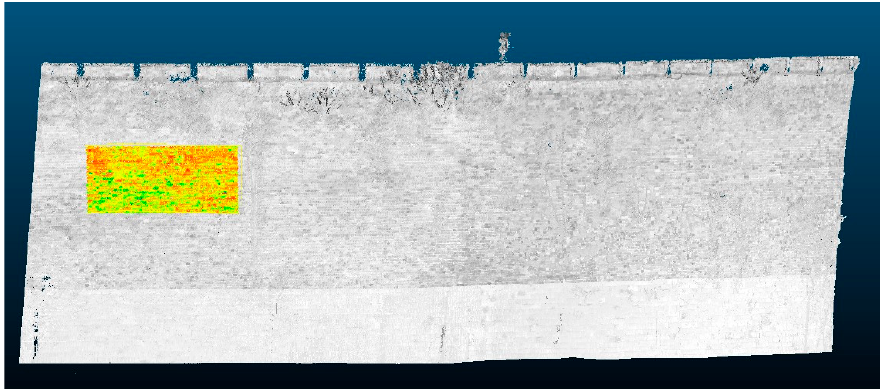
Figure 12. Data segmentation diagram. (The color in the fi gure is rendered with the intensity information of the point cloud, and the size of the cropping area is about 6 × 12 m).